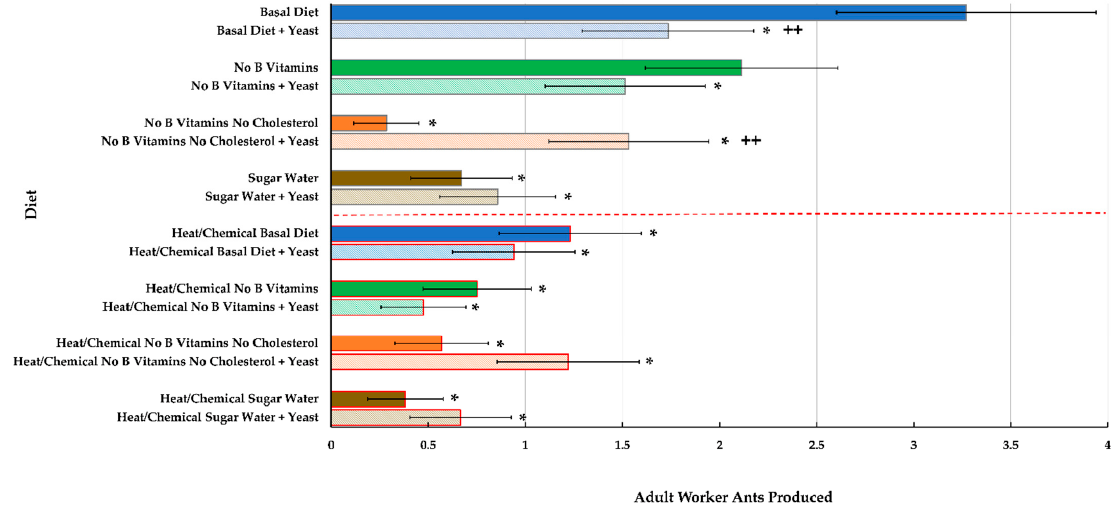
Figure 4. Estimated mean number of adult worker ants produced at the end of 12 weeks for groups of workers and larvae of the ant C. vicinus either not exposed or exposed to a heat/chemical defaunation (red line and red border bars) and fed eight different diets where various components were deleted and/or augmented with exposure to live yeast ( S. polymorphus ). Comparisons were made for all diets to the basal (all component) diet non-defaunated treatment (top blue bar), as well as with regard to yeast exposure or no yeast exposure. An asterisk (*) indicates p < 0.05 compared to the basal diet; double plus (++) indicates p < 0.05 compared between same diet with and without yeast.